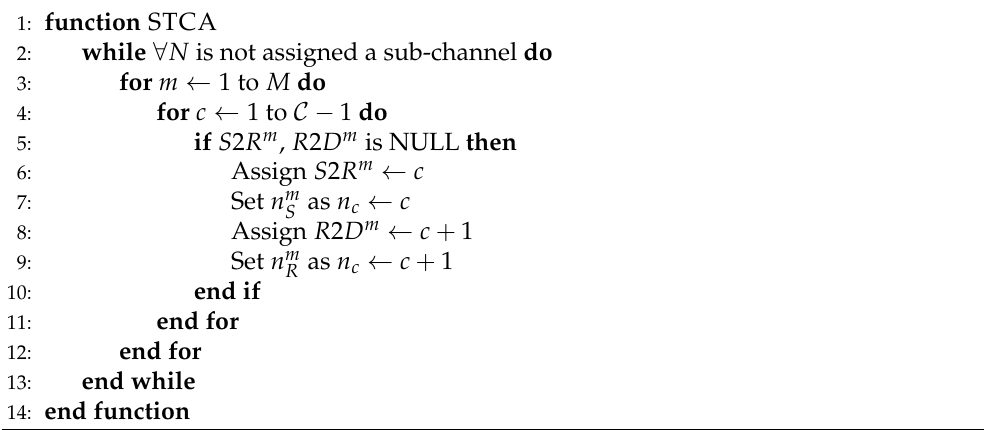
Algorithm 3 SR Transmitting Channel Allocation Algorithm